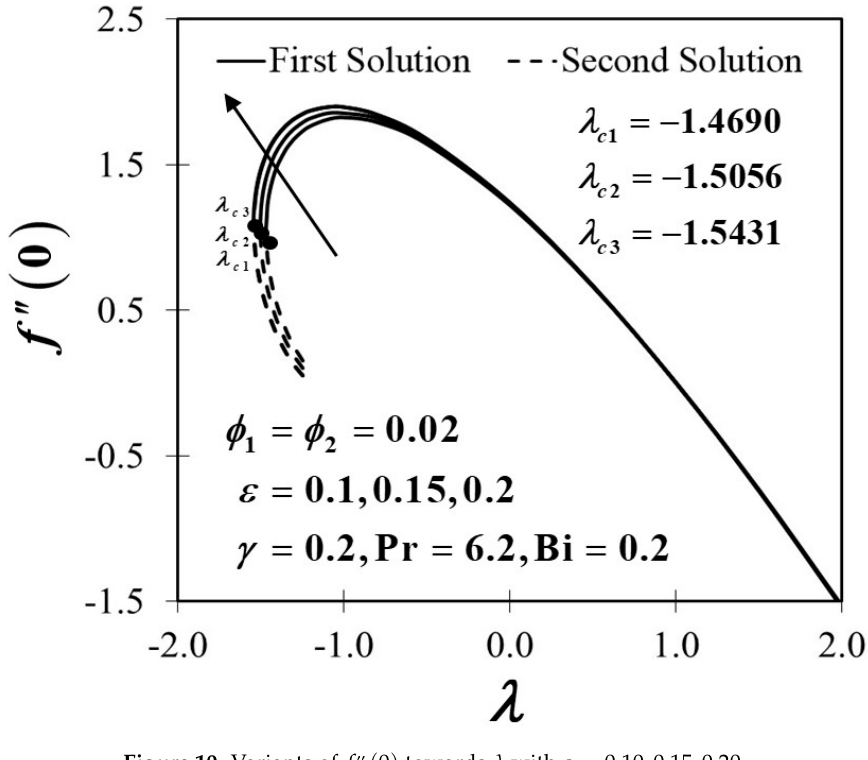
Figure 10. Variants of